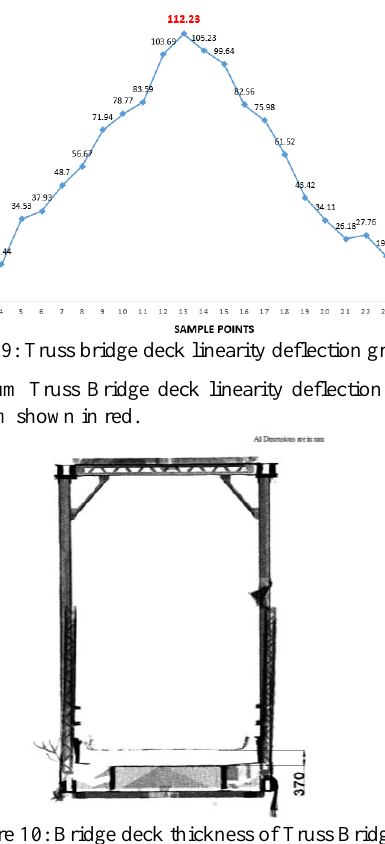
Figure 15: Beam Bridge deck linearity deflection